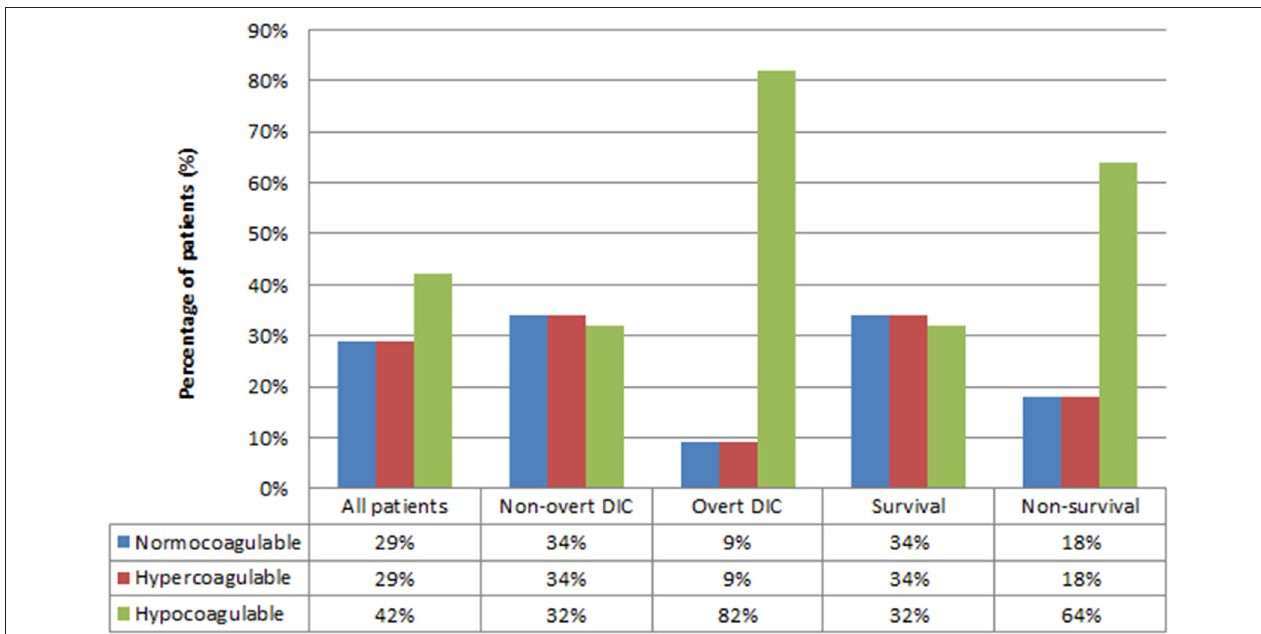
FIGURE 2 | Coagulation profiles based on rotational thromboelastometry test. DIC, Disseminated intravascular coagulation. P -value for Chi-square test of three coagulation profiles for all patients = 0.41, non-overt DIC = 0.978, overt-DIC = 0.003, survival = 0.974, non-survival = 0.023.